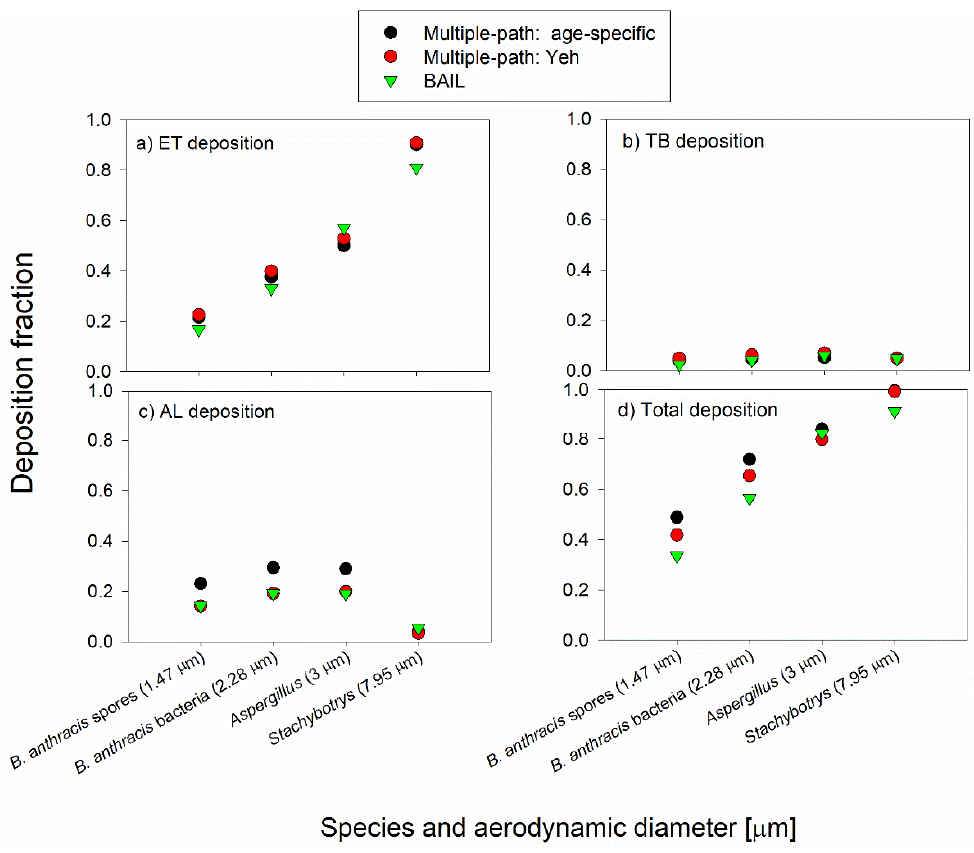
Figure 2. Regional and total deposition fraction for the default scenario: ( a ) ET deposition, ( b ) TB deposition, ( c ) AL deposition, and ( d ) total deposition.